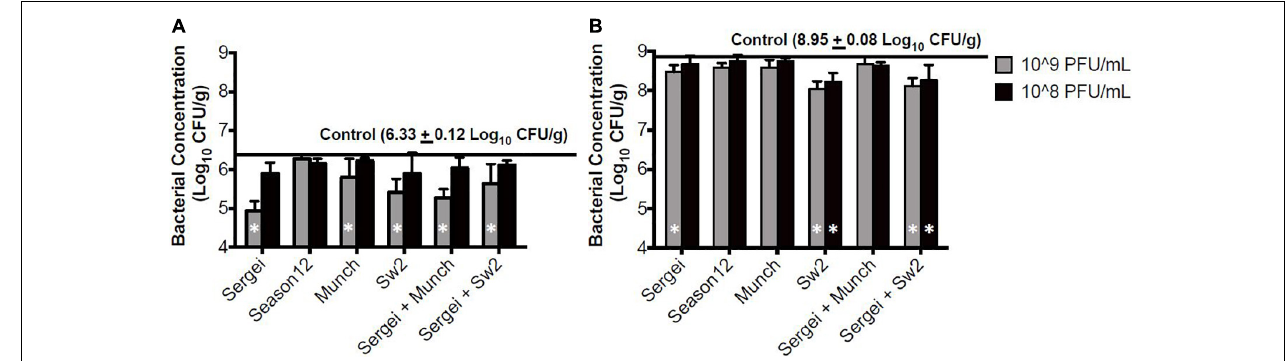
FIGURE 4 | Bacterial survival after phage treatments in the sterile soil model. (A,B) indicate bacterial survival following phage treatments of 1 and 24 h, respectively. Bar shading indicates two phage treatment concentrations at 10 8 and 10 9 PFU/mL, and the solid line parallel to the X -axis indicates the bacterial load in the positive (no phage) control. Error bars indicate standard deviation across three biological replicates. White stars in the bars represent significant difference in the treatment from the positive control. The detection limit of this assay is 2 log 10 CFU/g.